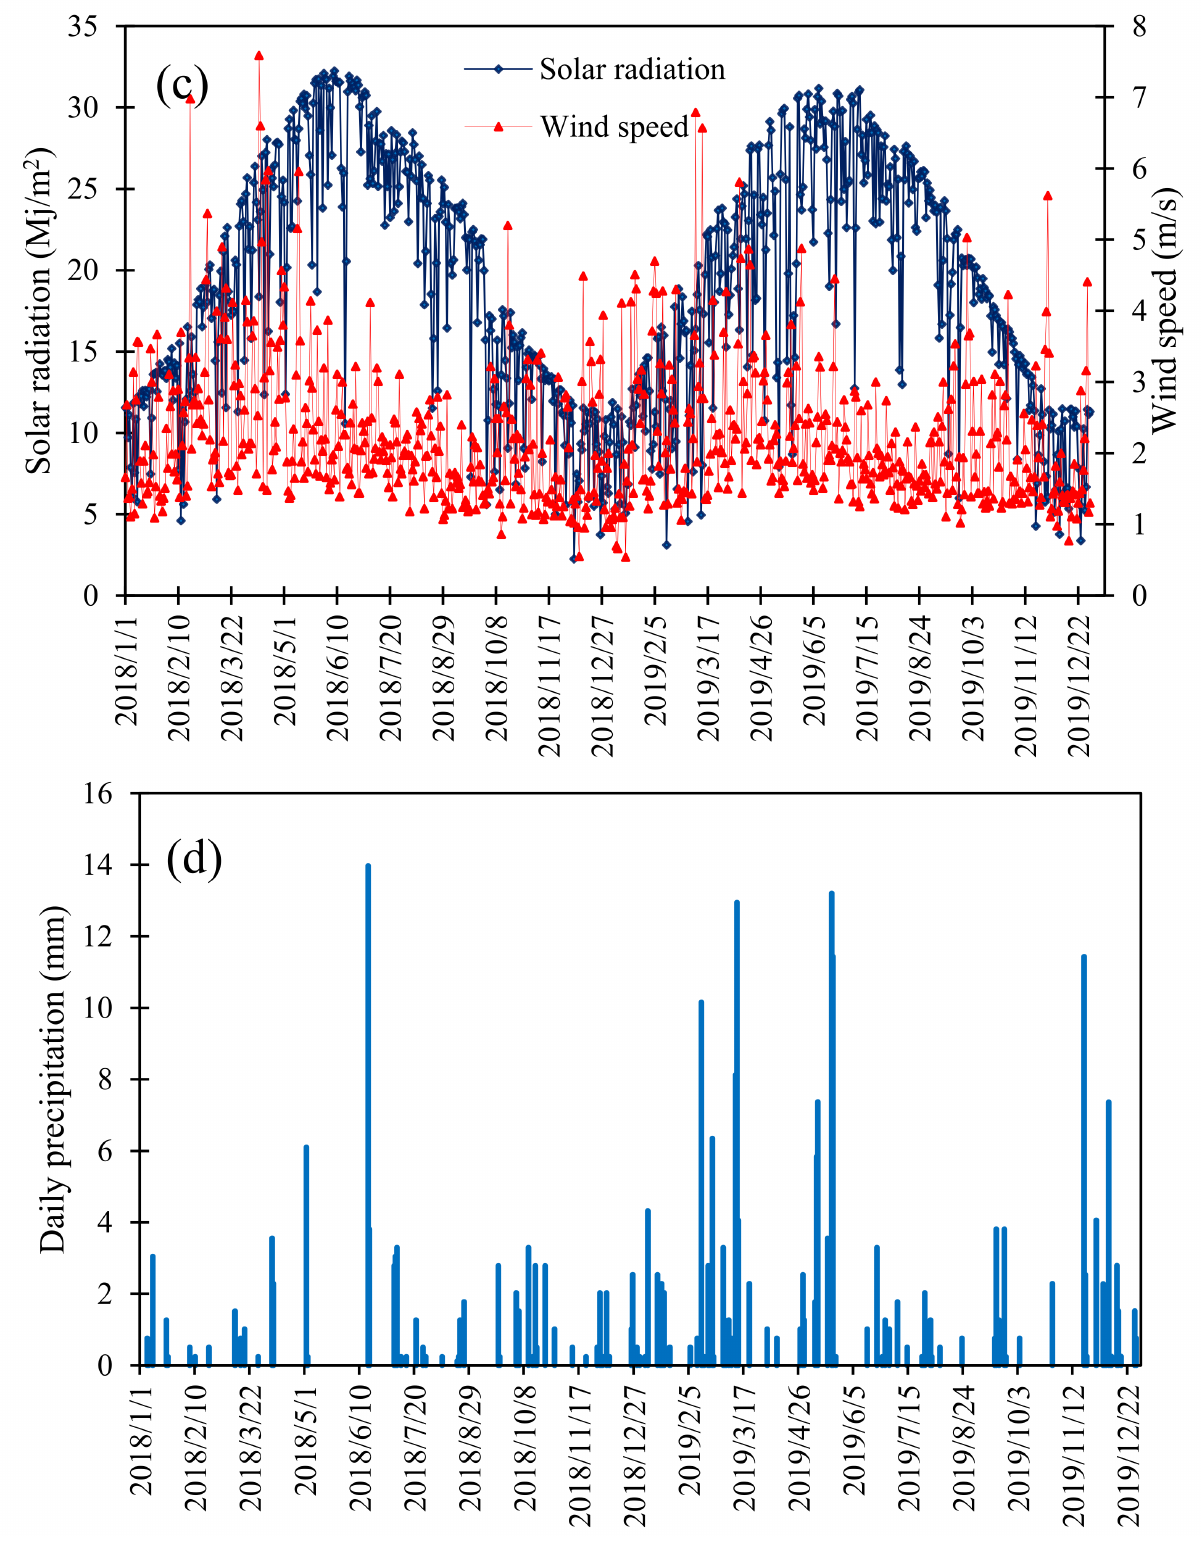
Figure 5. Daily air temperature ( a ), relative humidity ( b ), solar radiation and wind speed( c ) and precipitation ( d ) during the 2018 and 2019 growing